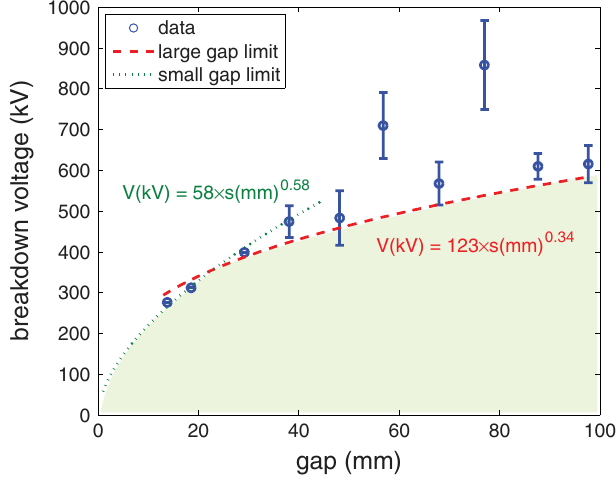
FIG. 3. Empiricaldata ofvoltagebreakdownasa function ofgap for planar electrodes, after [16], including fits used in constraining solutions. The filled area shows allowed values. Here, s is defined as the shortest distance between the cathode and